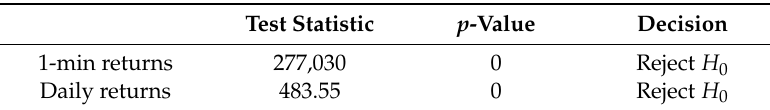
Table A2. Jarque Bera test.